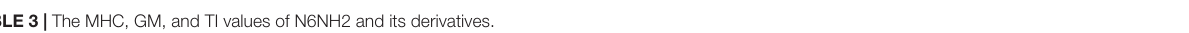
TABLE 3 | The MHC, GM, and TI values of N6NH2 and its derivatives.